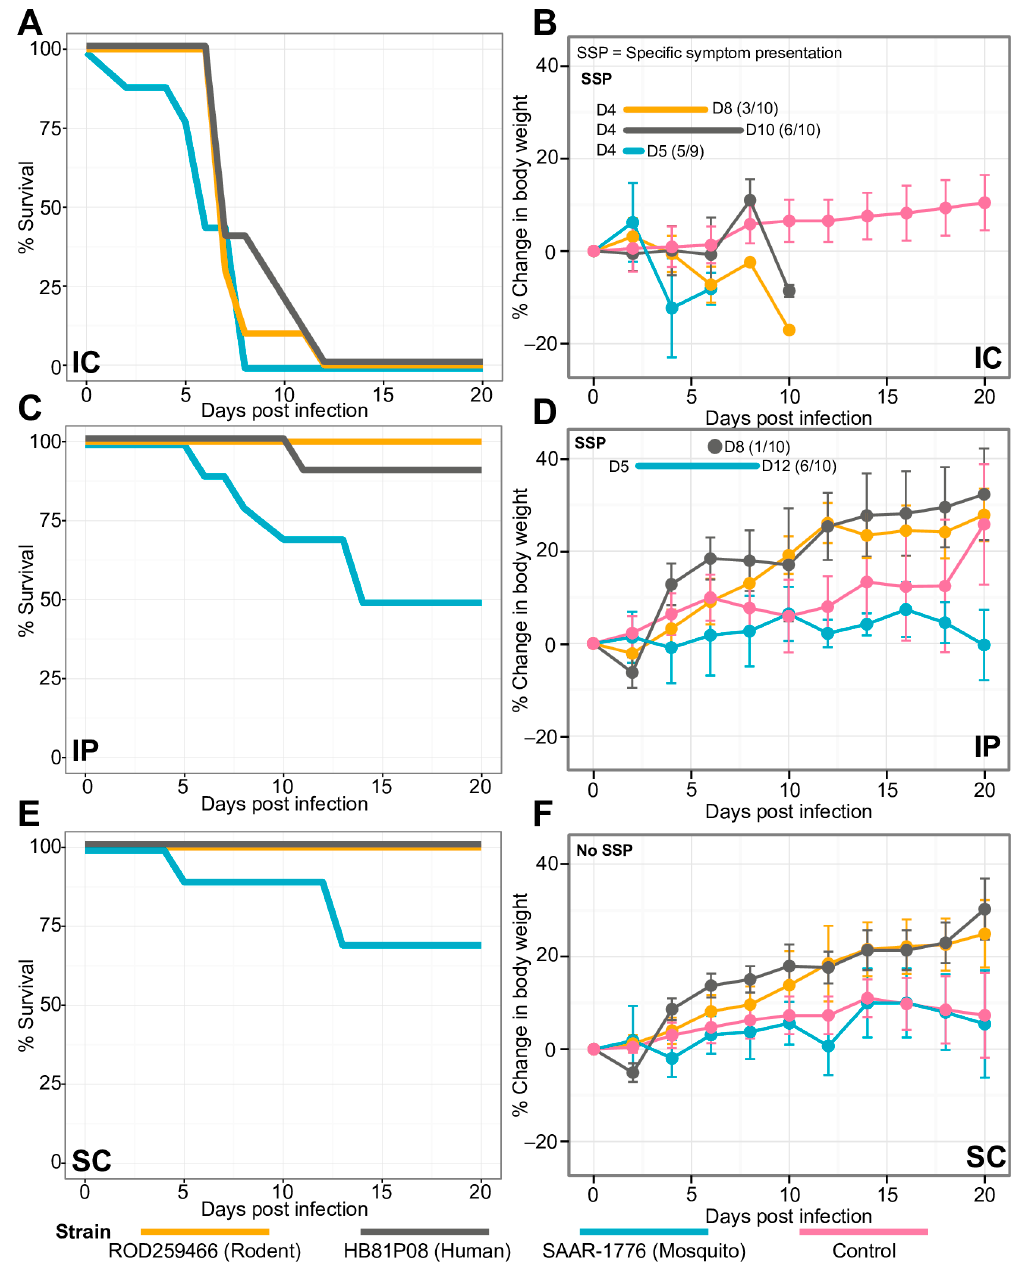
Figure 4. The in vivo evaluation of mouse mortality and virulence of three Usutu virus strains inoculated in 3-to-4-week-old Swiss mice. Survival (left panels) and changes in body weight (right panels) were observed after three different inoculation methods: intracerebral (IC, panels ( A ) and ( B )), intraperitoneal (IP, panels ( C ) and ( D )), and subcutaneous (SC, panels ( E ) and ( F )) for 20 days, post-infection period. The control mice (red) were injected with PBS in duplicate groups using the same inoculation methods. Error bars show the 95% confidence intervals for each sampled time point. The days of disease-specific symptom presentations (SSP) is shown in the top left corner of panels (B), (D) and (F). The number of days (D) post-infection when disease-specific symptoms are shown for each strain, as well as the proportion of symptomatic mice in each group.